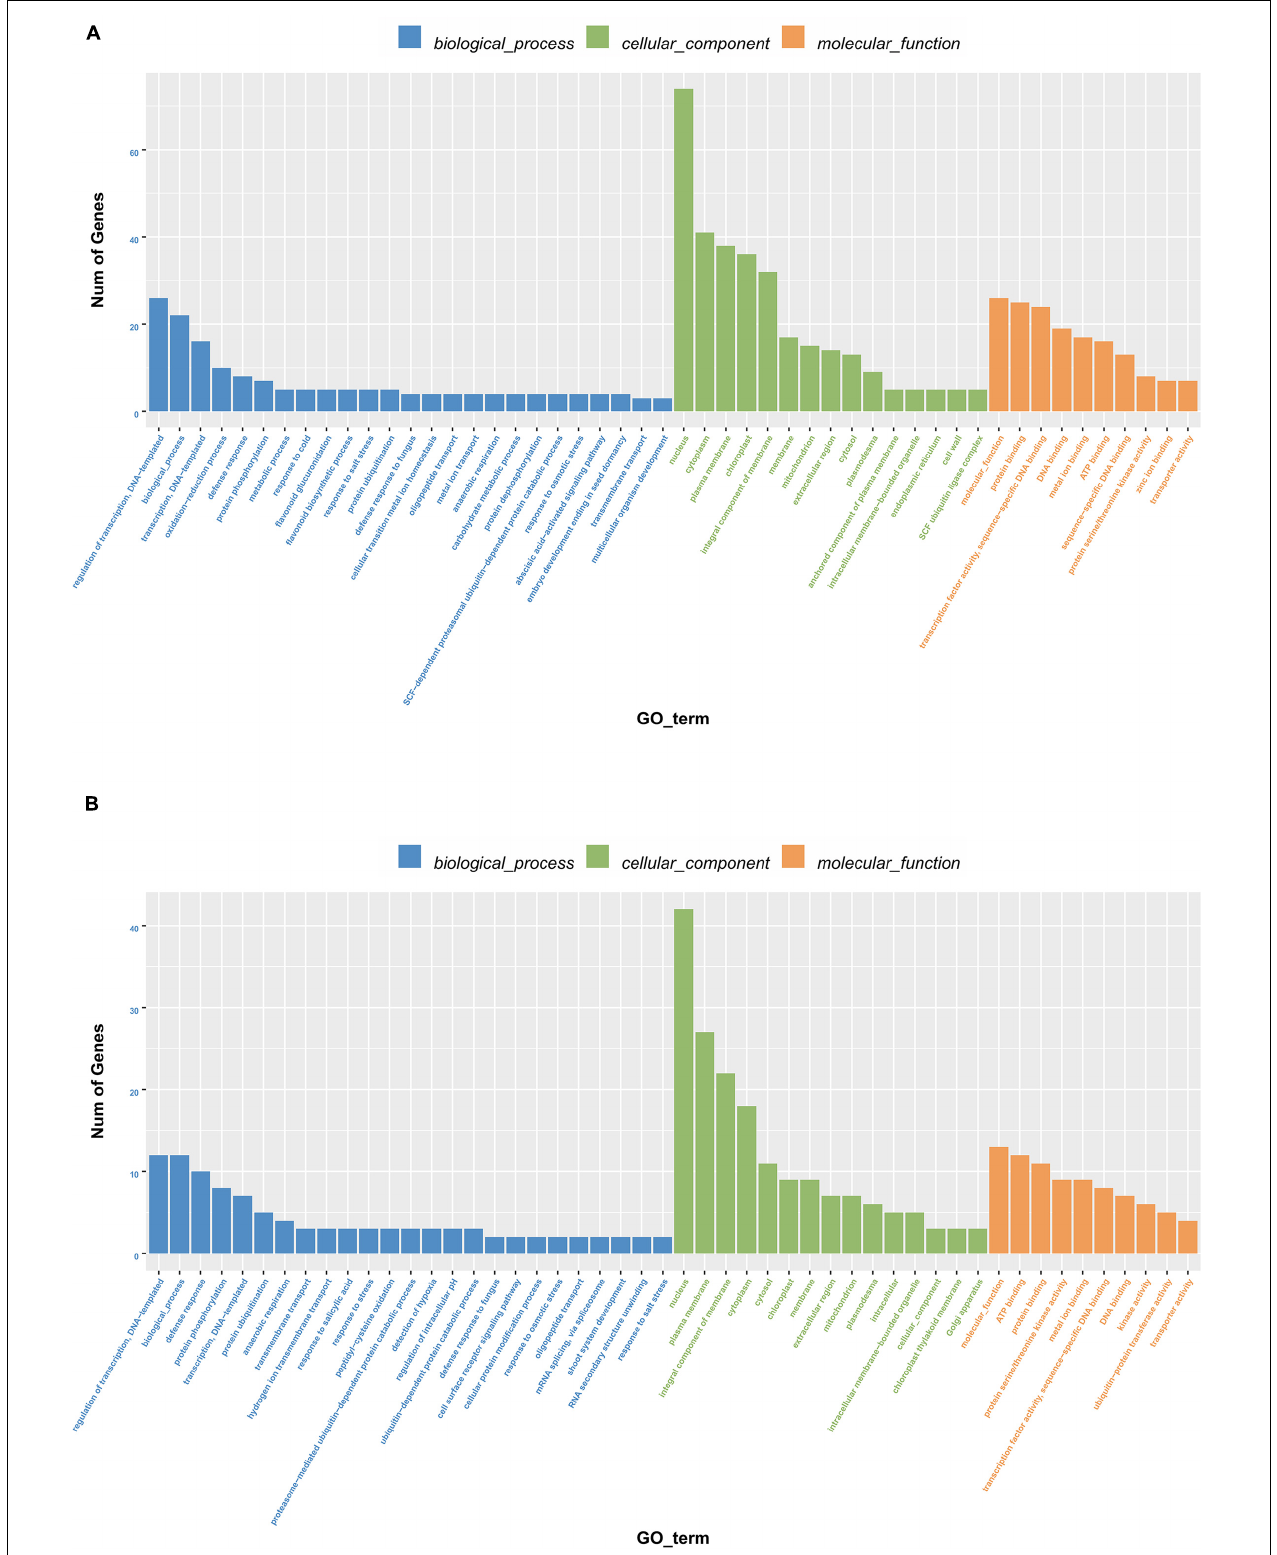
FIGURE 3 | Gene ontology enrichment of 13 lncRNAs as ceRNA regulated protein-coding genes in M-81E (A) and Roma (B) . The y-axis represents the number of genes and the x-axis represents the GO functional group.